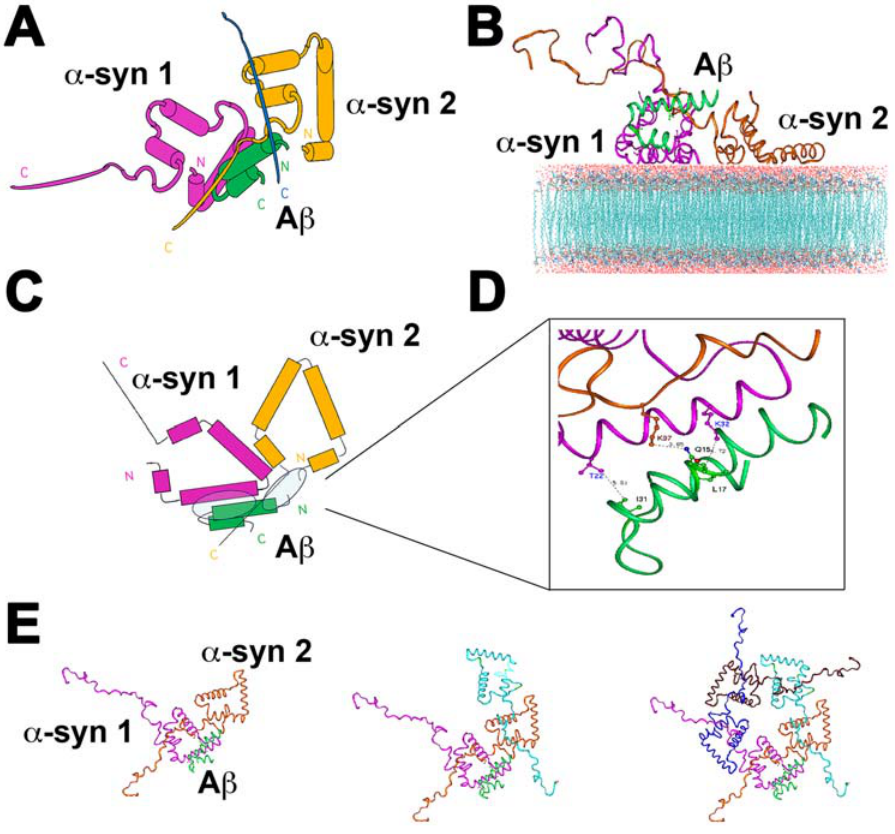
Figure 2. Molecular dynamics studies of the interactions of one A b monomer with membrane-docked a -syn multimers. ( A ) Diagrammatic representation of the complex formed between the 2 ns A b conformer and the 4 ns a -syn dimer, composed of two molecules of a -syn ( a -syn1 and a -syn2). ( B ) Molecular modeling of the A b monomer/ a -syn dimer complex docked to the membrane. ( C ) Diagrammatic representation of predicted interactions between the A b monomer and the two a -syn molecules occur primarily between the N-terminus of A b and the N-terminus of the a -syn molecules (circled regions). ( D ) Specific residues involved in interactions between the A b monomer and the two a -syn molecules. ( E ) Docked complex of A b and the a -syn dimer or higher-order oligomers (trimer, pentamer) form a ring-like structure on the membrane.